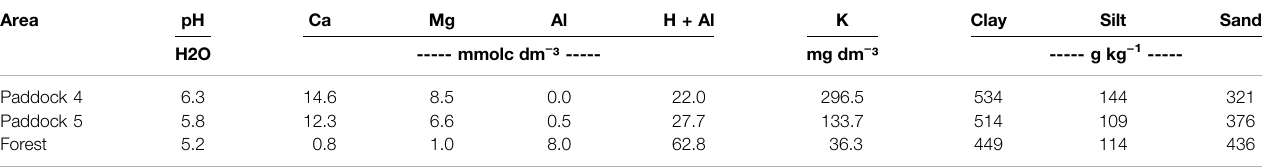
TABLE2| Meanselectedsoilchemicalpropertiesandsoilparticle sizedistributions forthesurface10 cmfortwopaddocksunderintegratedcrop-livestocksystemsandan adjacent forest at Santo Antônio de Goiás, Goiás State, Brazil. Area pH